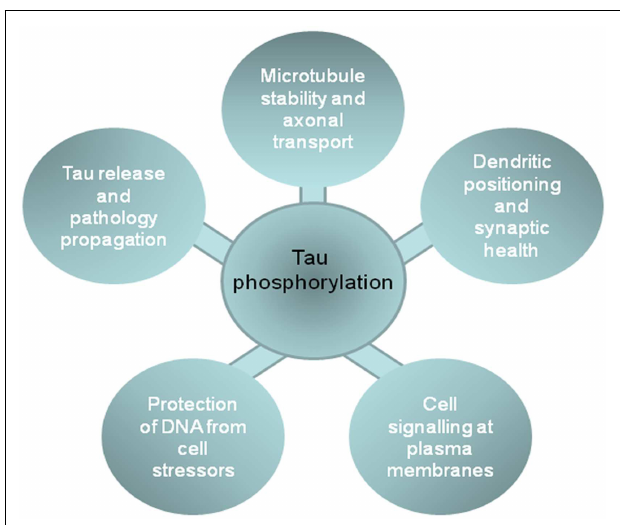
FIGURE 2 |The impact of phosphorylation on tau functions in different cell locations .The figure shows the functions of tau in different cellular compartments that are influenced by tau phosphorylation, and that likely contribute to the development or progression of neurodegenerative